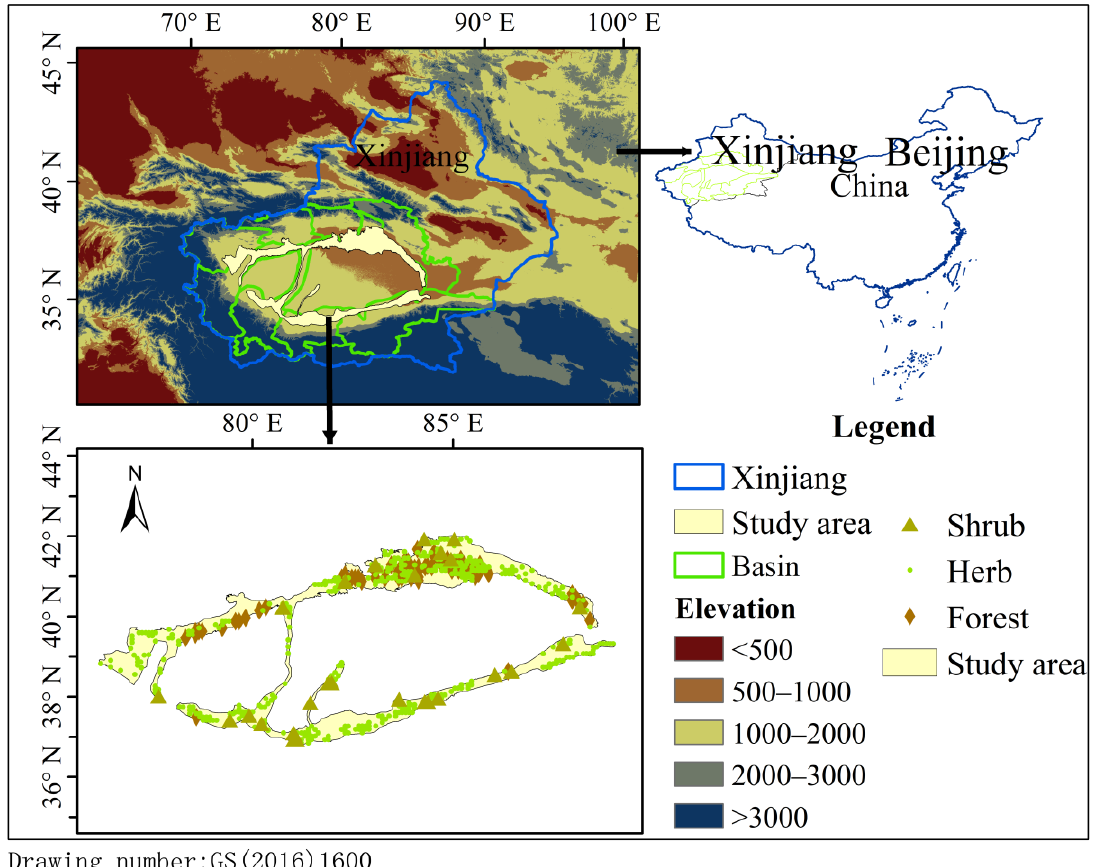
Figure 1. Map of the study area within the Tarim River Basin, Xinjiang,